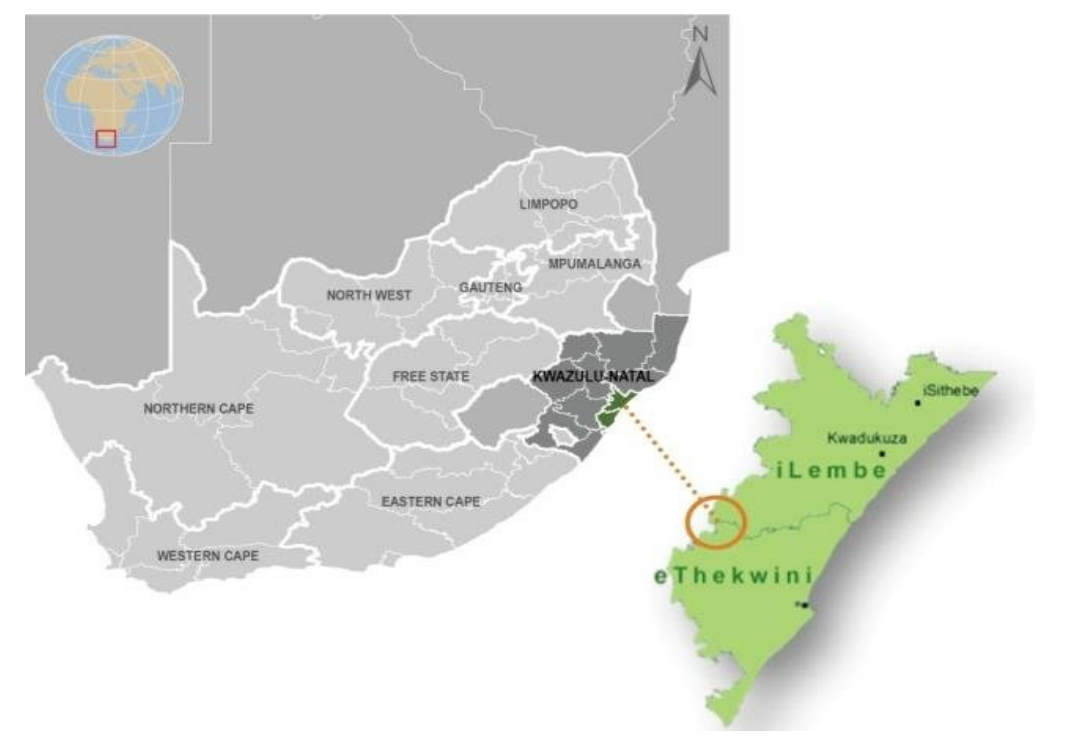
Figure 1. Map showing the location of Inanda to eThekwini Municipality. Source: Lincoln [26].